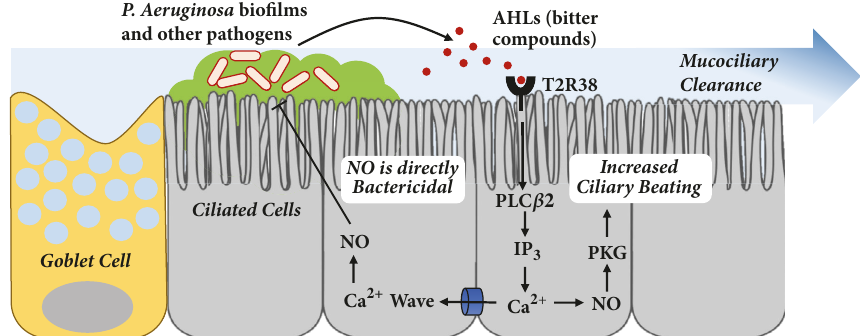
Figure 1: Bitter taste receptor, T2R38, is expressed on ciliated cell and mediates innate immune response to bitter compounds, such as AHLs secreted by P. aeruginosa. Innate immune defences include nitric oxide (NO) production as well as increased ciliary beating.